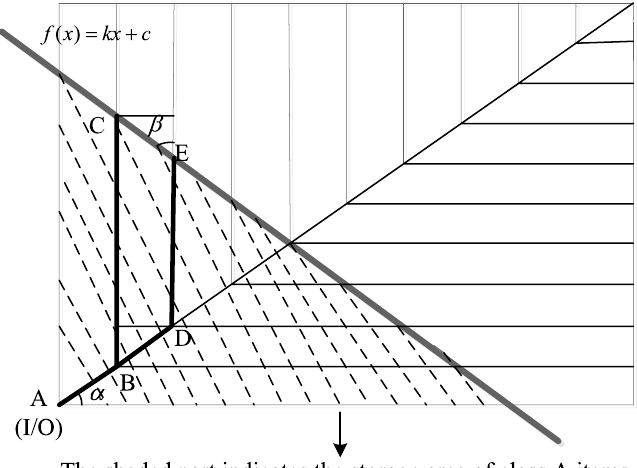
Figure 3. ABC class-based storage strategy in the fishbone layout